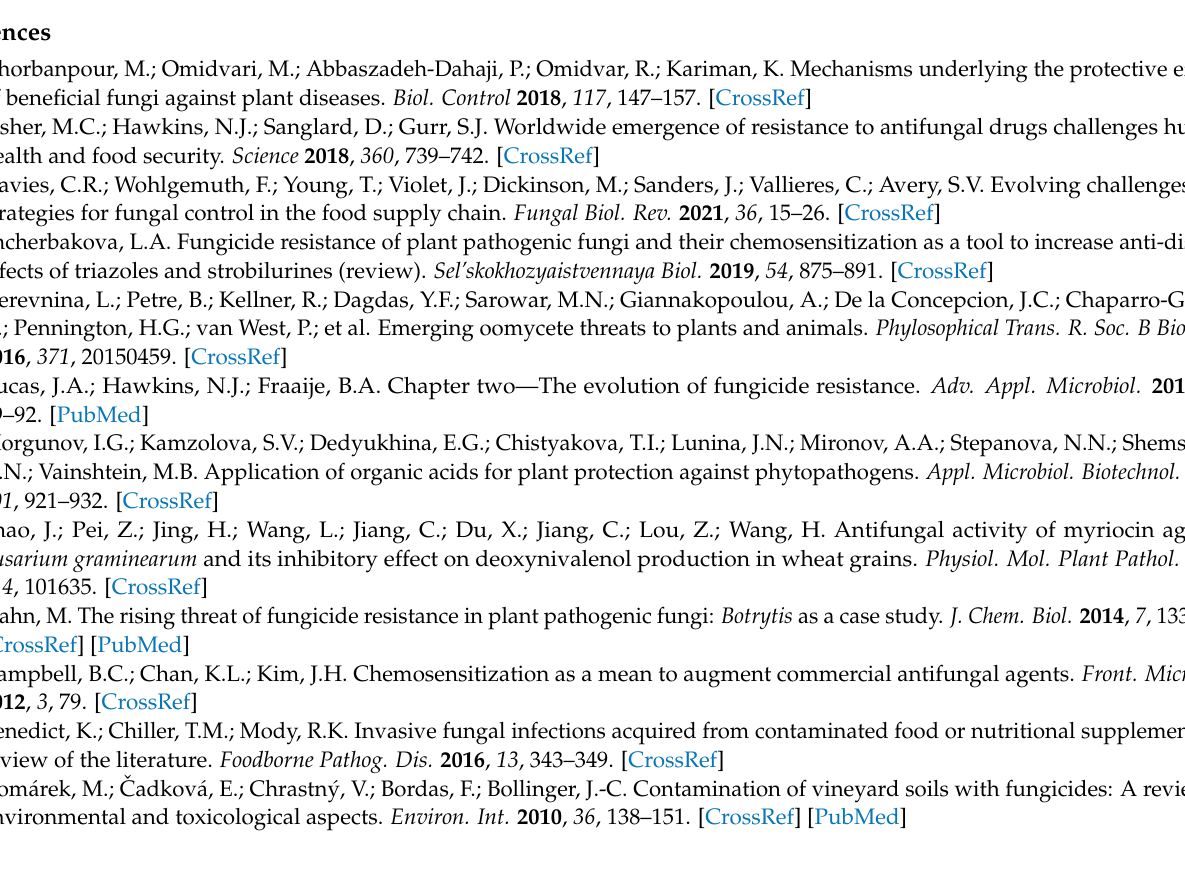
gene from Penicillium chrysogenum F-24-28 determined using the 18S F566-18S R1200r primer system. Figure S2: Nucleotide sequence (567 bp) encoding the intergenic region of the ribosomal operon from Penicillium chrysogenum F-24-28 (ITS1-ITS4